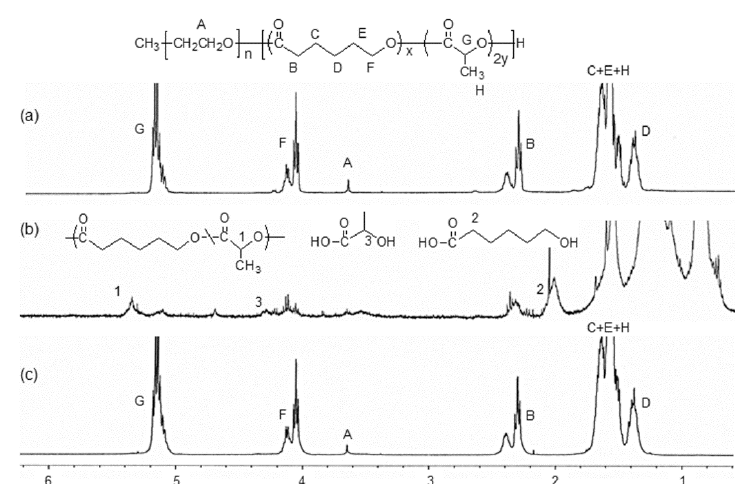
Figure 2. Proton nuclear magnetic resonance ( 1 H-NMR) spectra ( a ) before; and ( b and c ) after 3 weeks of in vitro degradation of Dex-NS; ( b ) n -hexane and ethyl ether soluble portions; and ( c ) insoluble portions.